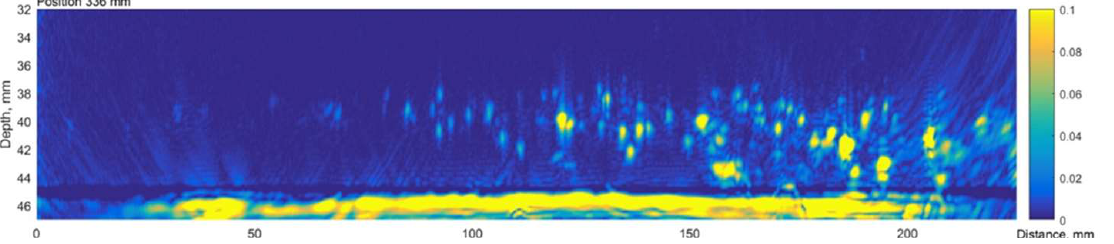
Figure 19. B-scan of the sample No.5 along the edge obtained by the TFM. The B scan corresponds to the section line, where the pipe was sliced before the metallographic examination. Vertical colour bar represents the peak-to-peak amplitude in arbitrary units.